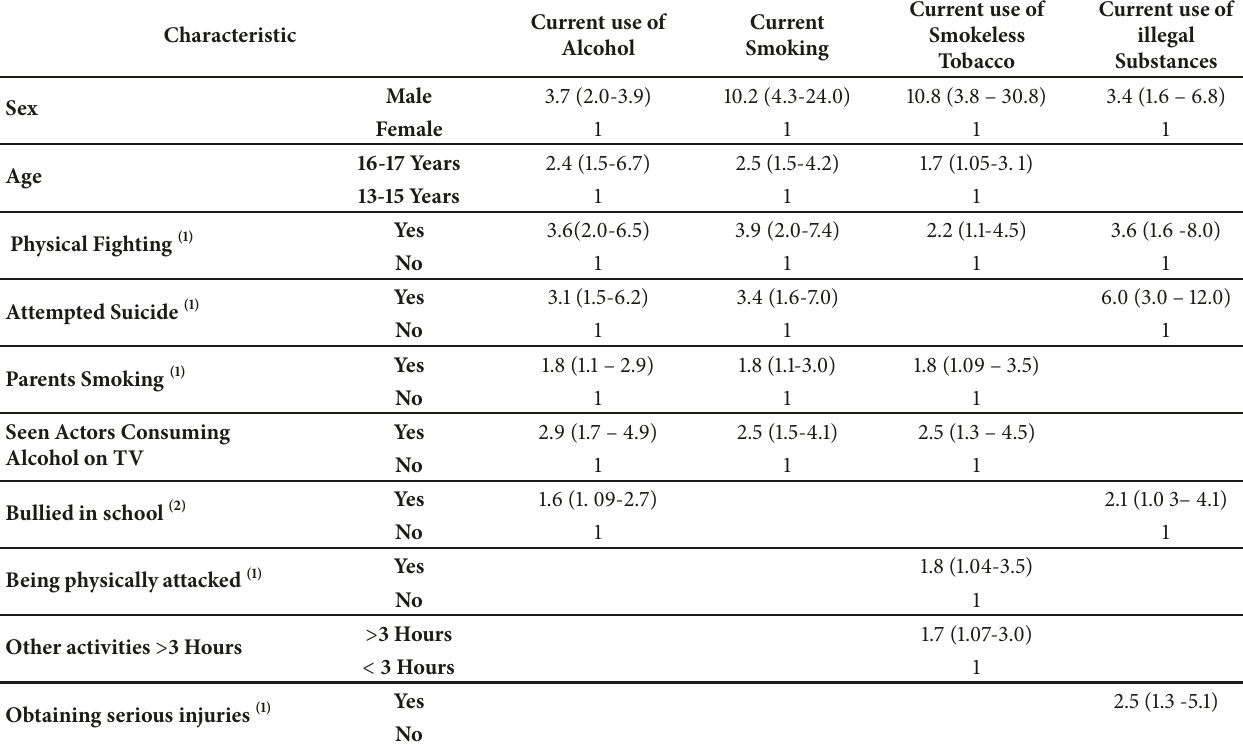
Table 4: Factors associated with current use of alcohol consumption, smoking, smokeless tobacco, and illegal substances (Adjusted Odds Ratios with 95%